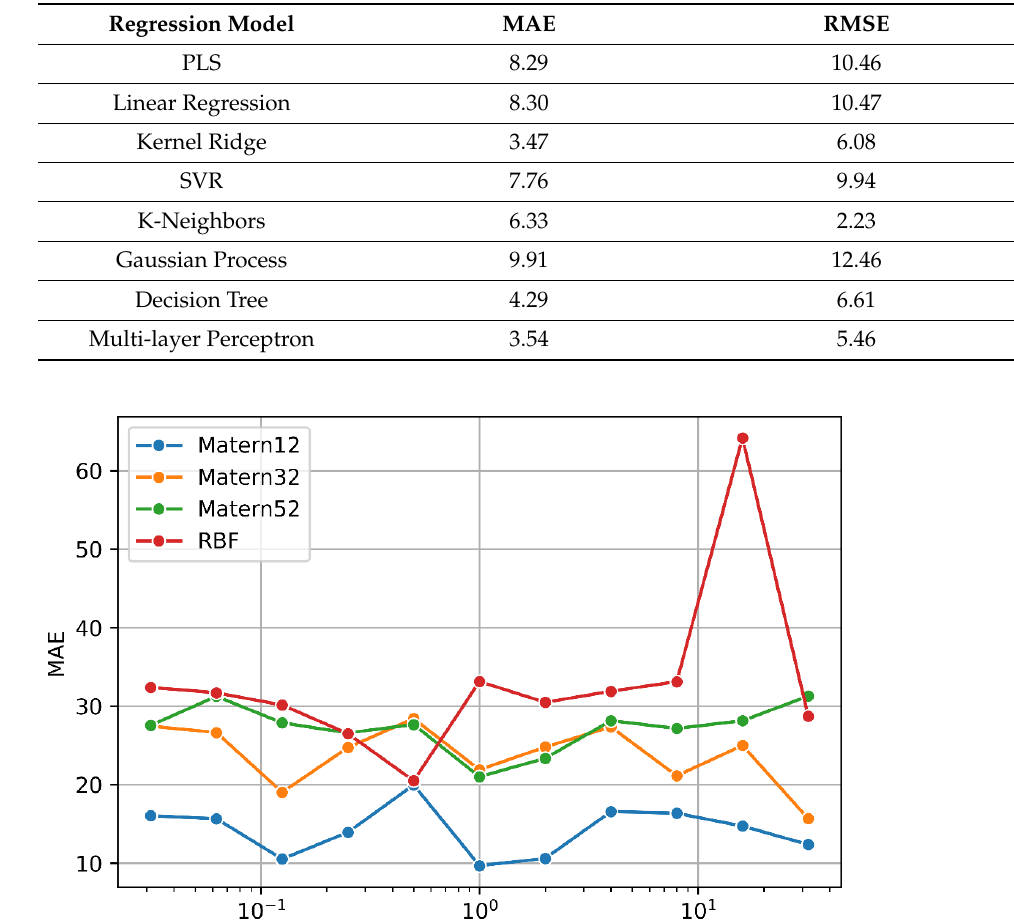
Figure 3. Selected kernel and related hyperparameter.